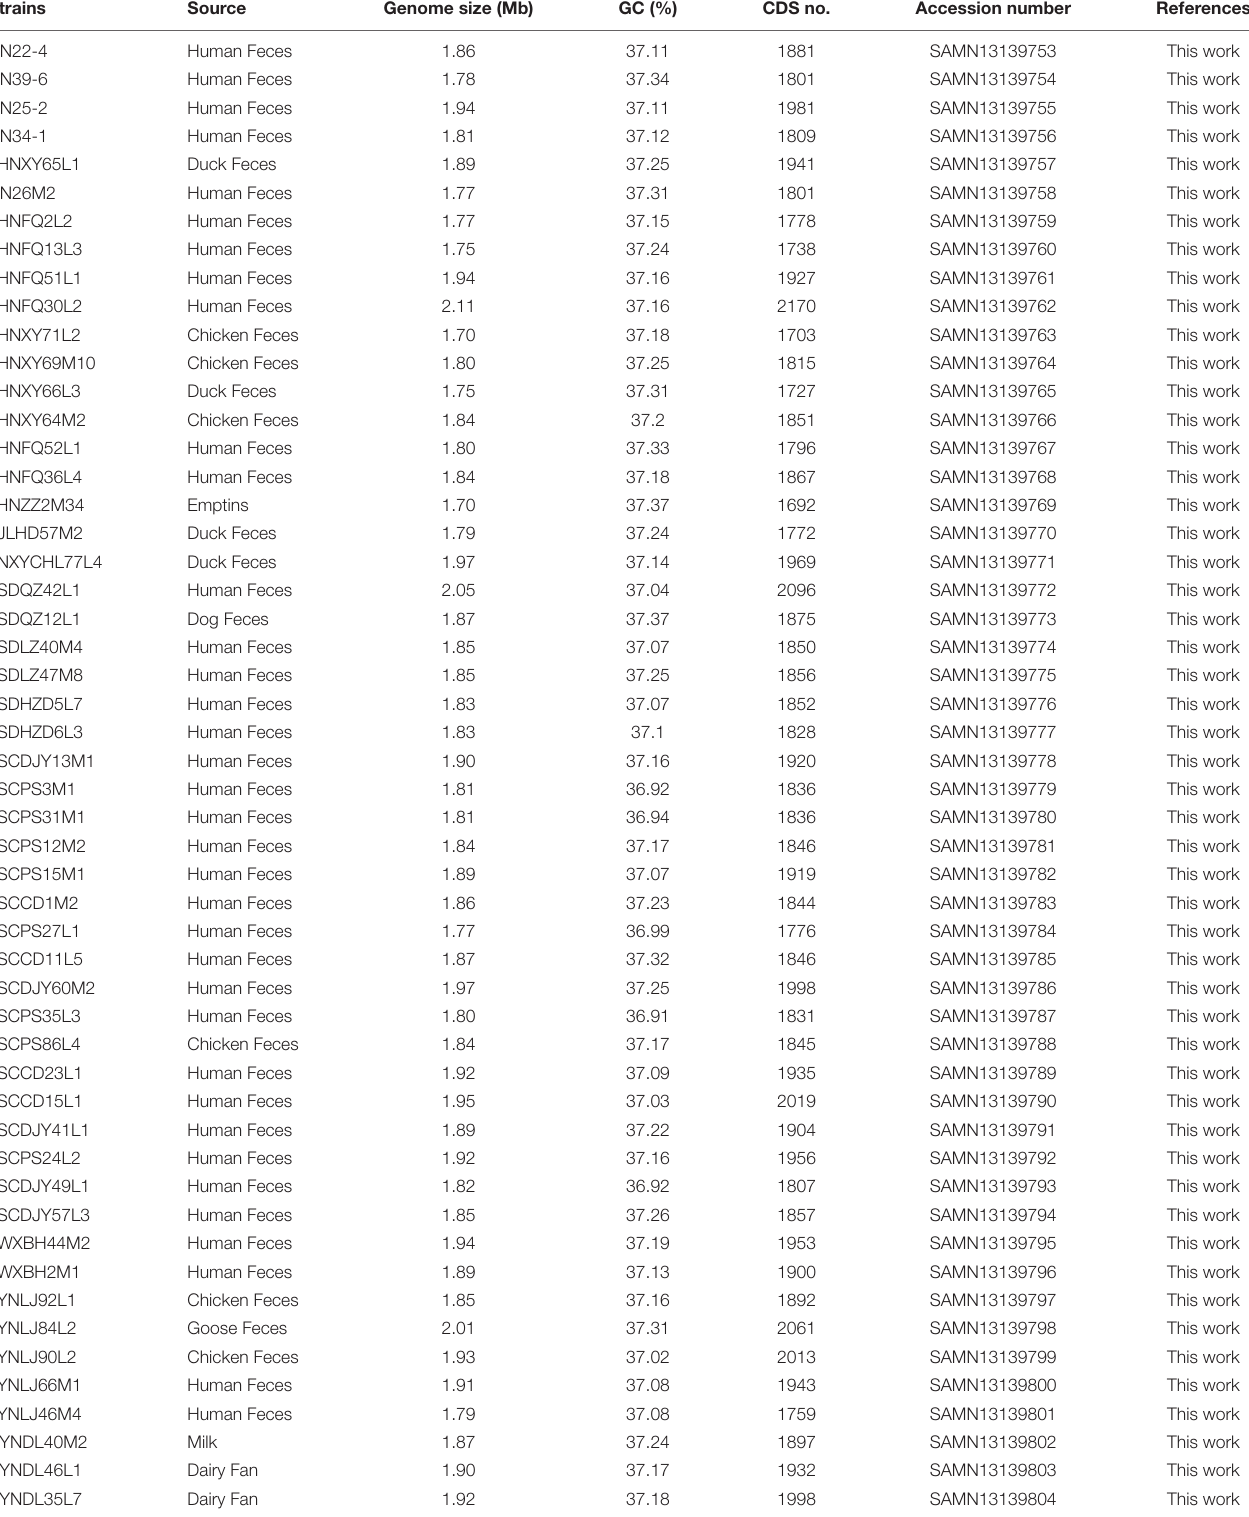
TABLE 1 | The information of 74 P. pentosaceus